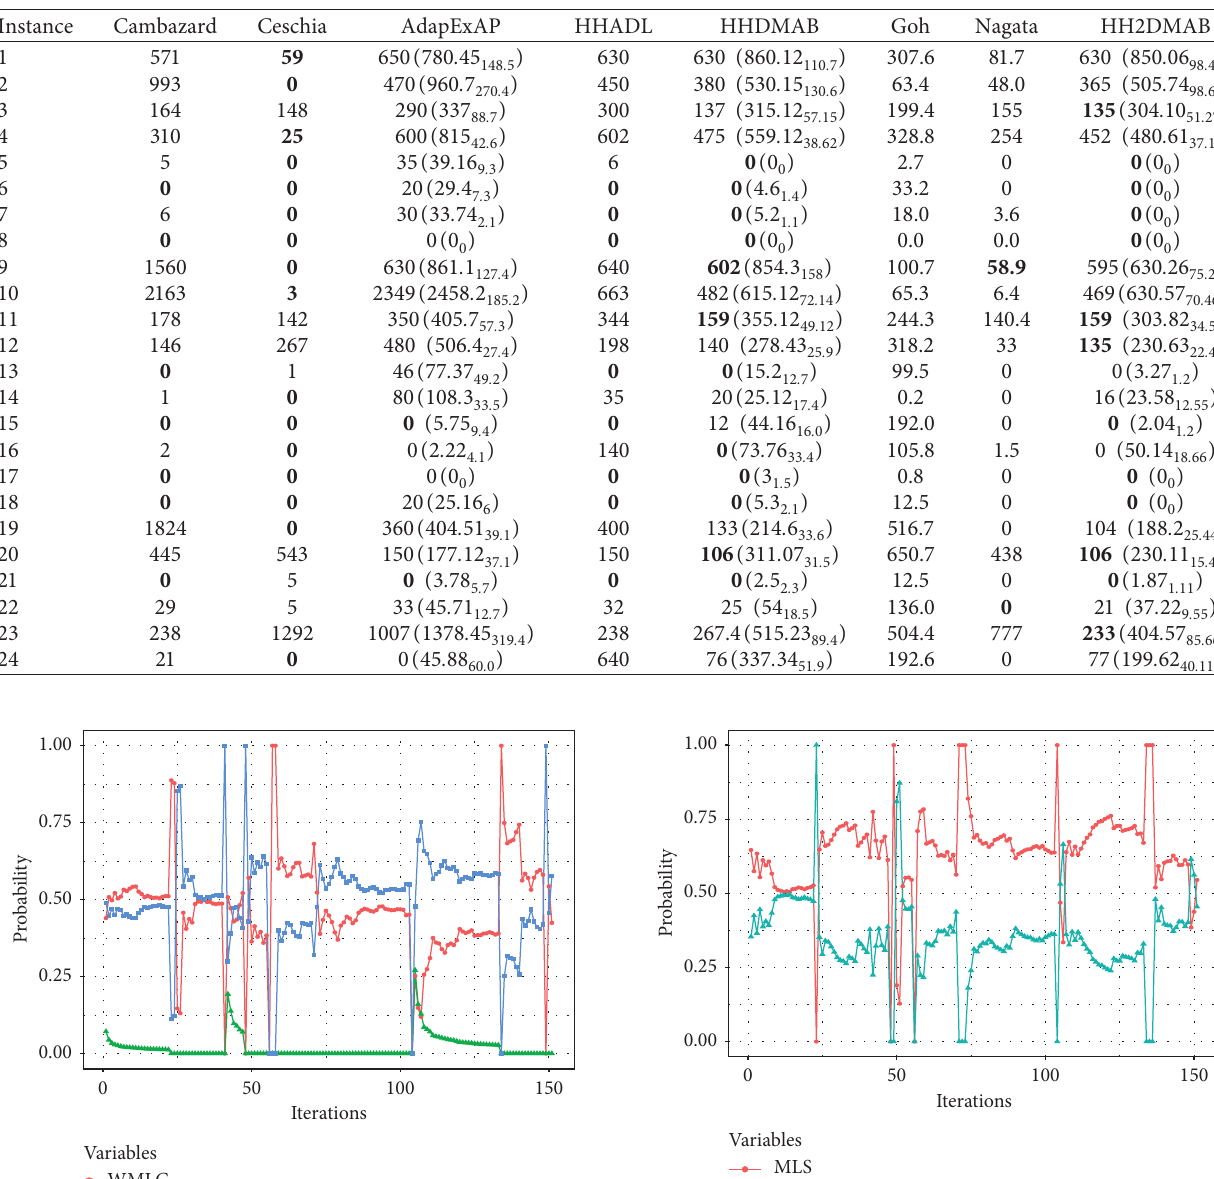
Table 3: Course timetabling problem. Comparison of our proposed approach HH2DMAB against state-of-the-art solvers. The evaluation of the best-found solutions are shown, with the average and standard deviation results reported in brackets in the form ( s The best solutions are given in bold font.